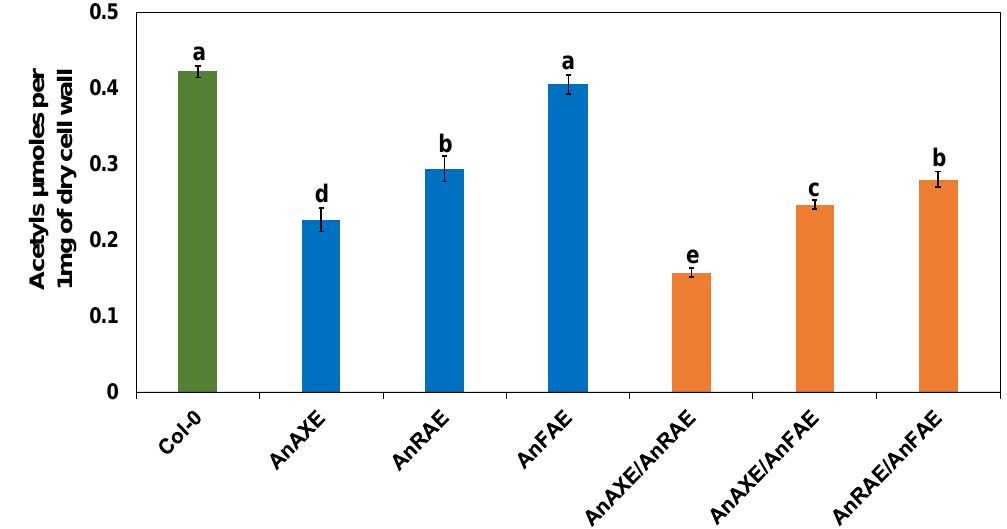
Figure 1. Cell wall acetylation of transgenic and WT plants (Col-0). Acetyl content is represented in µmol per mg dry CW material. Data represent the average ± SD of three different independent transgenic plants of each construct and three WT plants. Letters (a–e) indicate the significant differences among the genotypes (Fisher’s LSD test, p < 0.05).